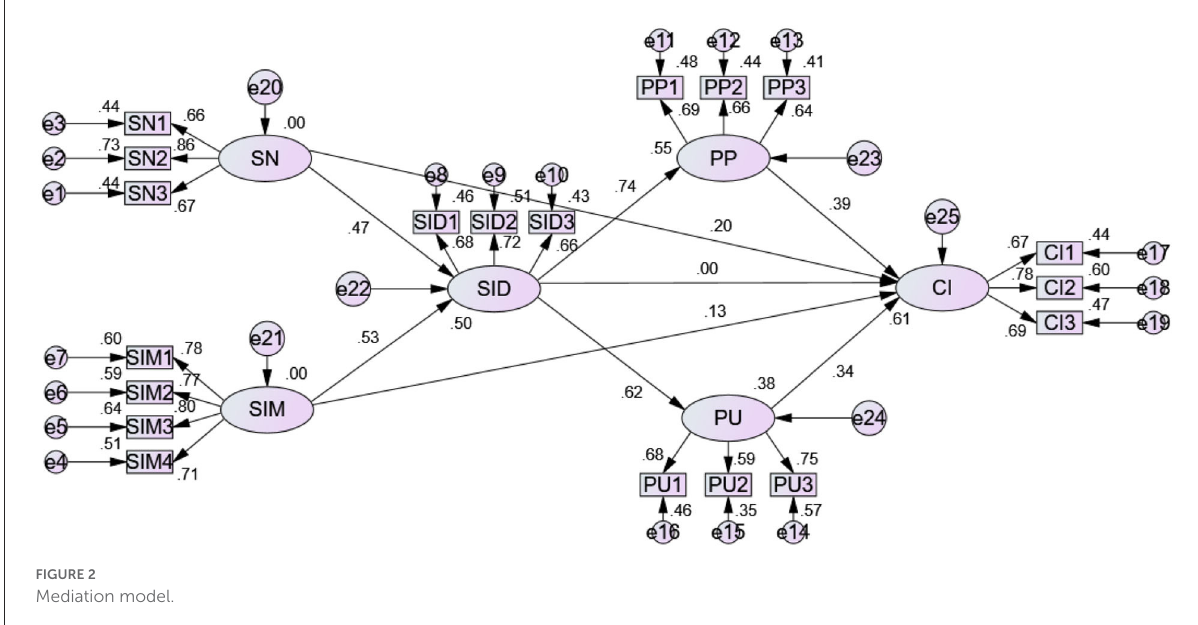
FIGURE2 Mediation model.